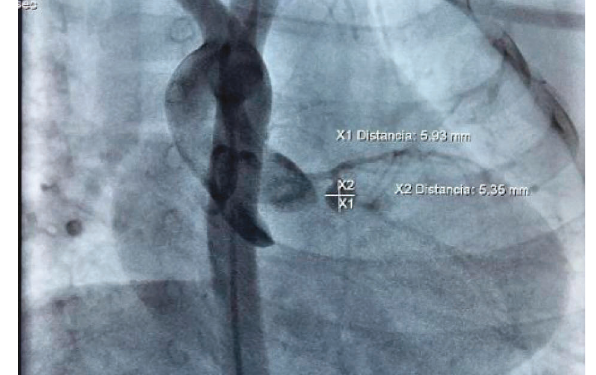
Figure 4: Cardiac catheterization: Aneurysm in the circumflex artery, measuring 5.9 mm × 5.3 mm without evidence of